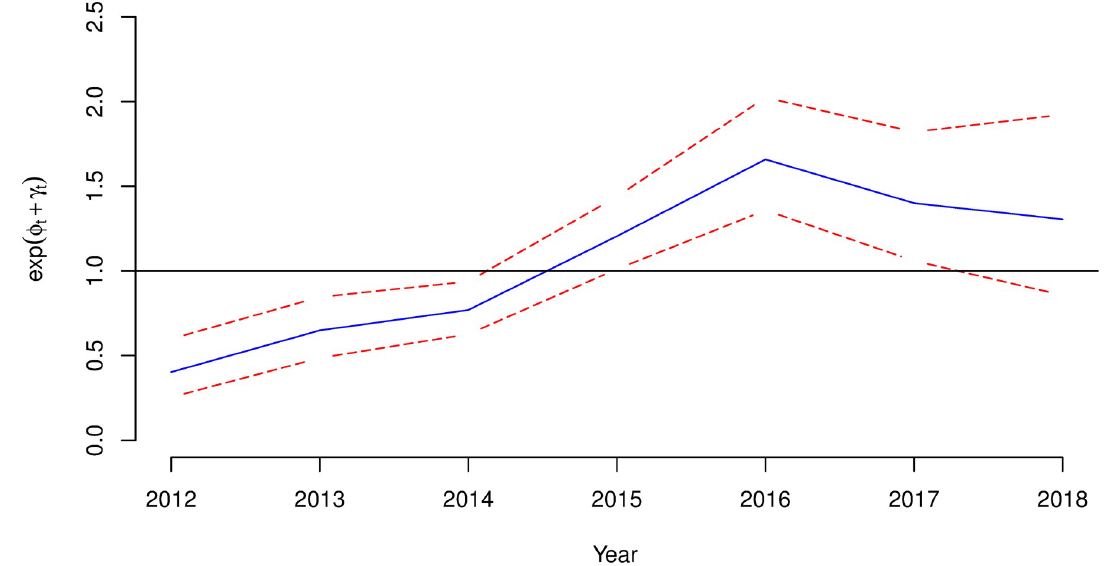
Fig 3. Posterior temporal trend effect for malaria relative risk in Rwanda: Exp( ϕ t + γ t ) with 95% credible